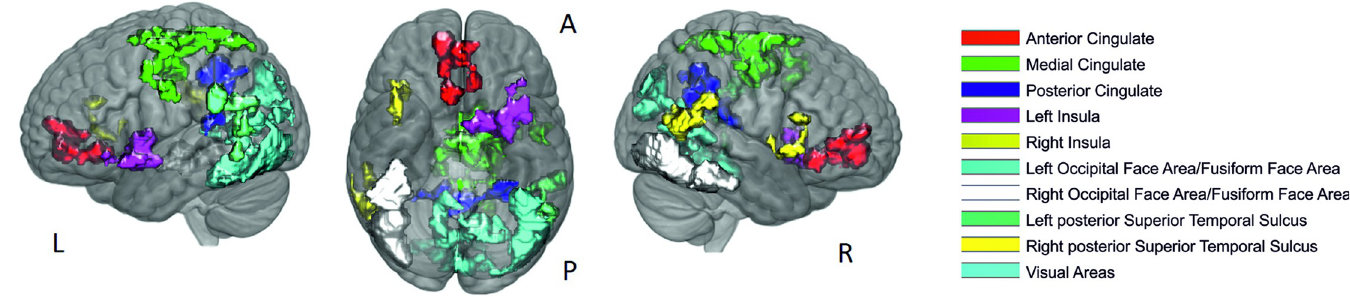
Fig 2. Regions of interest extracted from activation clusters in left and right view (L and R) and ventral view (A: anterior and P: posterior region).